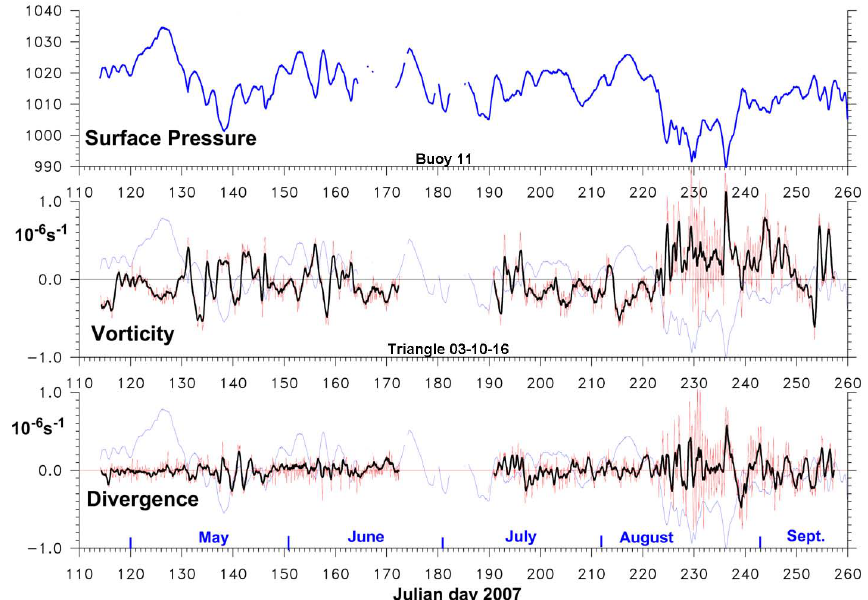
Fig. 9. Time series of ice-drift vorticity and divergence in the D07 buoy triangle 03-10-16 with 2h resolution (red) and as 12h running mean (black) together with the sea-level pressure at buoy 11 in the middle of the triangle. To ease visual correlation the pressure is repeated as thin curve in the vorticity and divergence